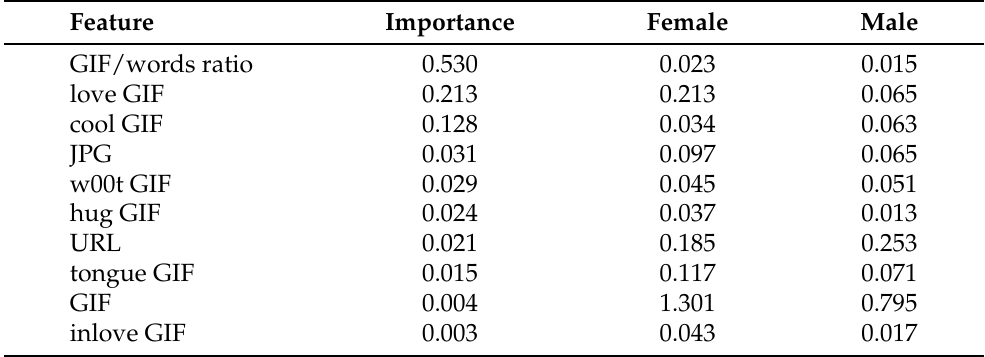
Table 8. Digital feature importance and mean